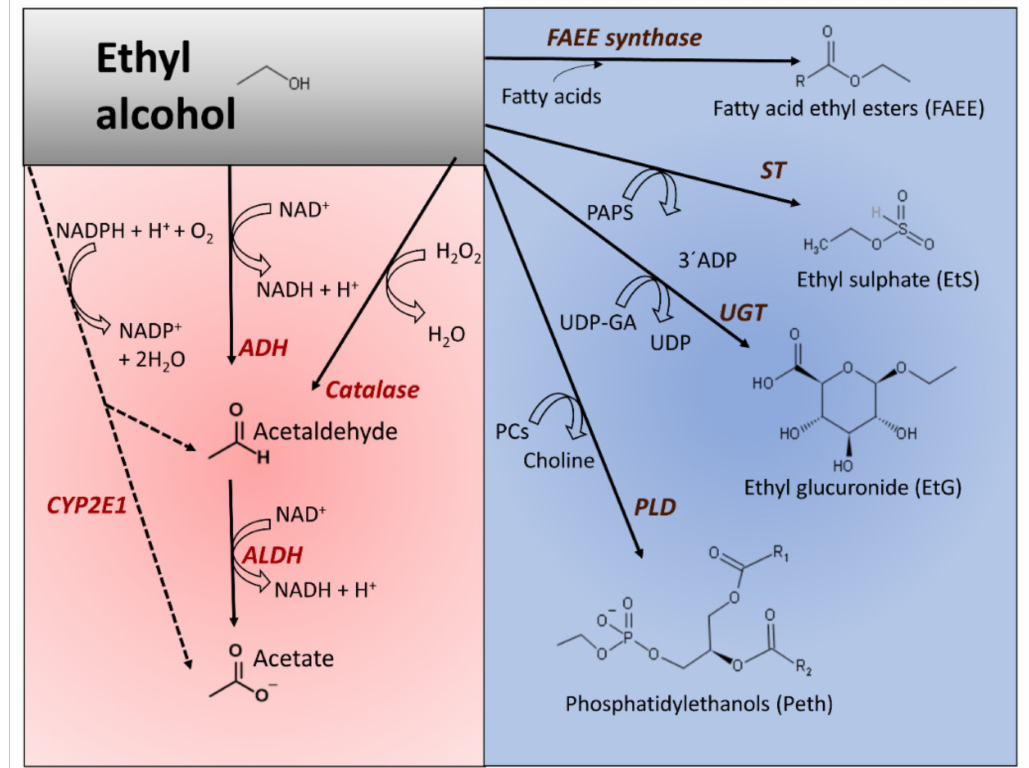
Figure 1. Schematic representation of ethanol oxidative (pink area) and nonoxidative (blue area) metabolism, including metabolites, principal enzymes catalyzing the transformations, and essential coenzymes. Alcohol dehydrogenase (ADH,